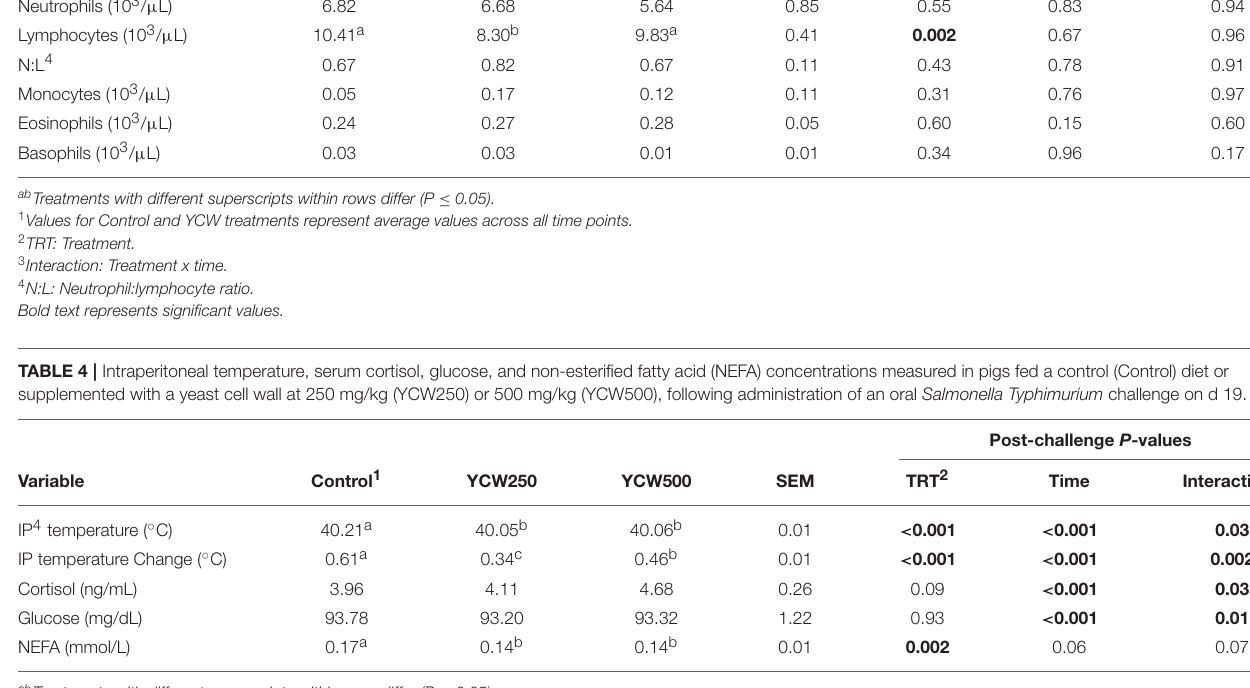
TABLE 3 | Complete blood cell count parameters measured in pigs fed a control (Control) diet or supplemented with a yeast cell wall at 250 mg/kg (YCW250) or 500 mg/kg (YCW500), prior to administration of an oral Salmonella Typhimurium challenge on d 19. Variable